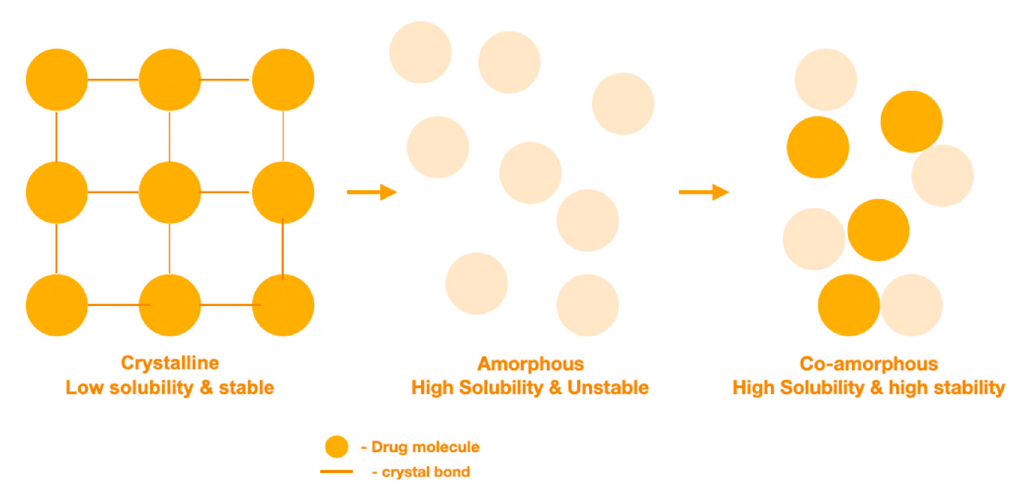
Figure 3. Illustration of the crystalline state, amorphous state and coamorphous state and their characteristics.